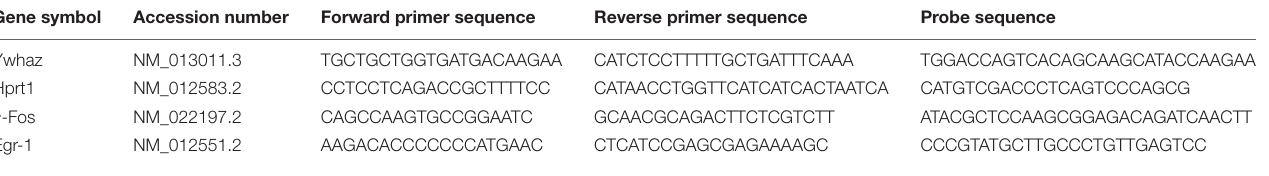
TABLE 1 | Primers and probe sequences used in RNA analysis, including gene symbol and accession number for the target